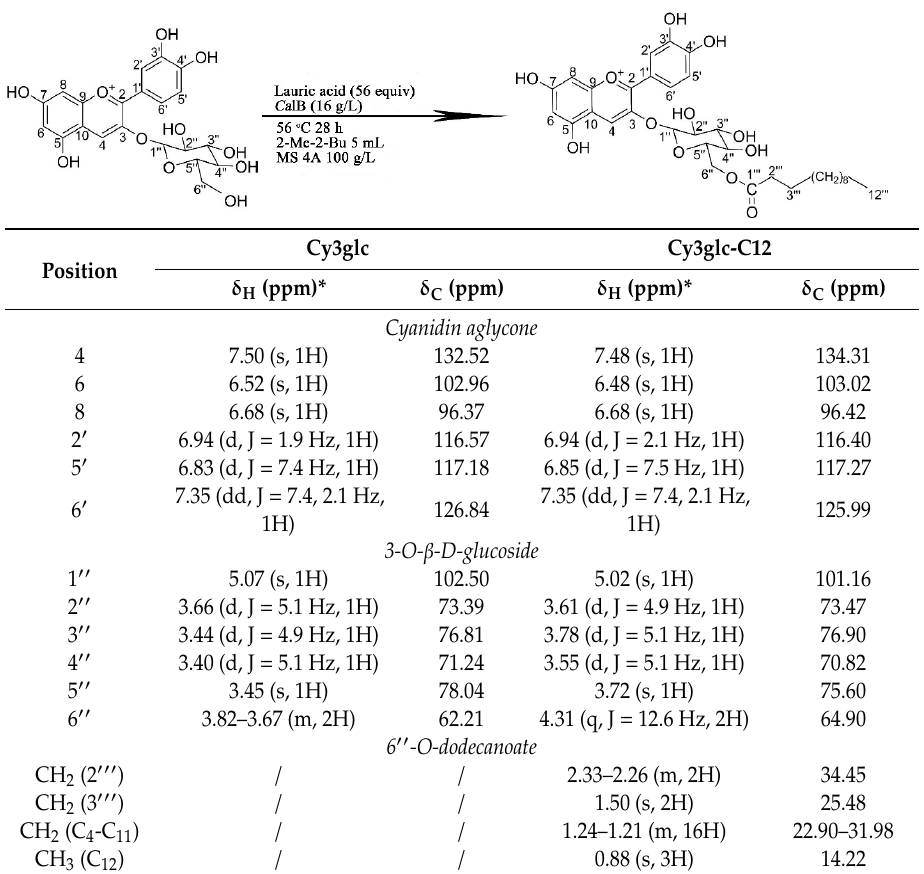
Biology 2020 , 9 , x FOR PEER Table 1. 1 H and 13 C NMR data of Cy3glc and Cy3glc-C12 in CD 3 OD + TMS.